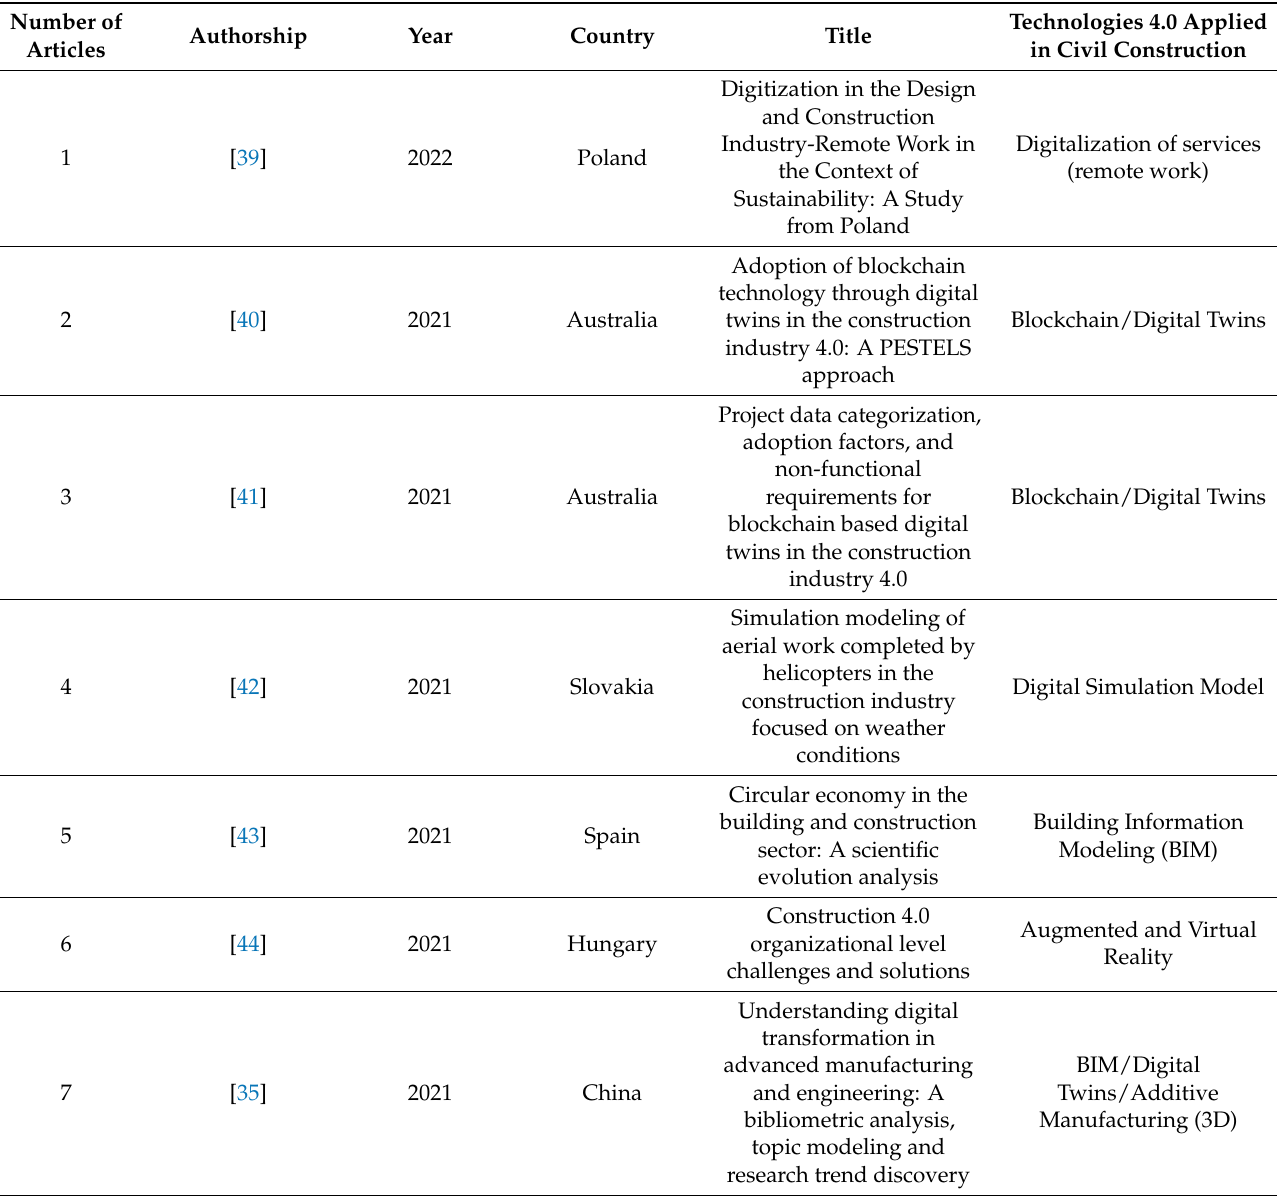
Table 2. Bibliographic Analysis